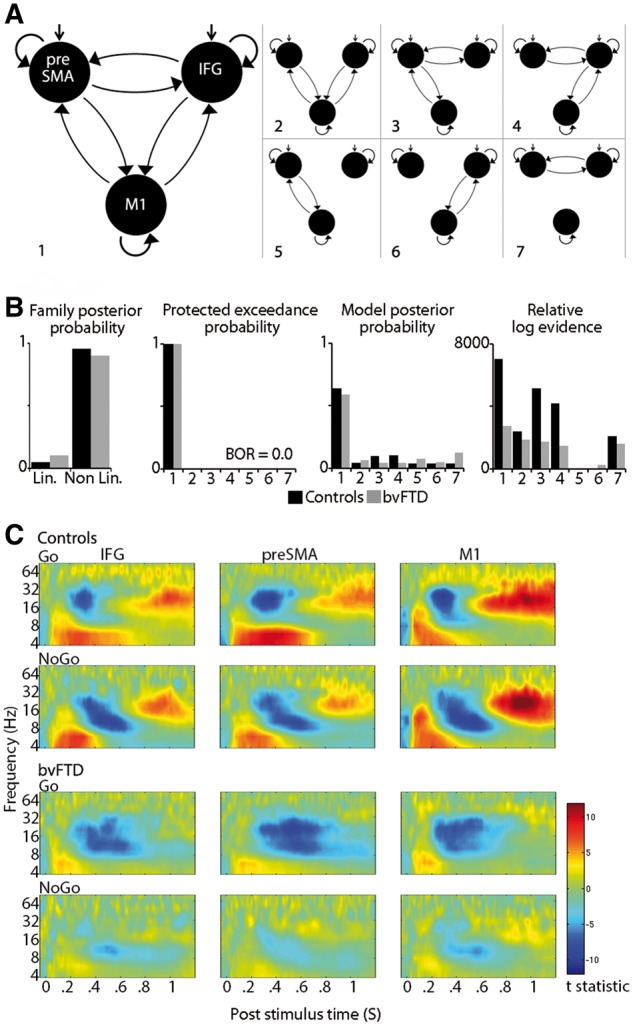

Details of dynamic causal models. (A) DCM model space with seven different architectures. (B) Bayesian model selection reveals the non-linear family best fitted the data, which allows for cross-frequency coupling. Of the seven models within the non-linear family, Model 1 was the winning model, with task modulation of reciprocal connections between all regions. For both controls and bvFTD patients, Model 1 had the greatest exceedance and posterior probabilities and a difference in log evidence between the winning and second best model > 3. (C) Time-frequency spectra for each region, for each condition and group.